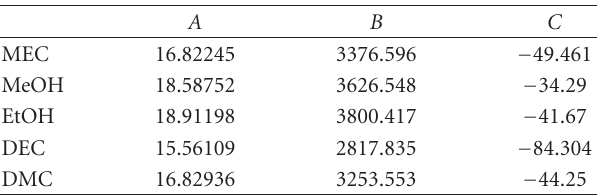
Table 5: The Antoine parameters. p o i is measured in (mmHg), and T is measured in [K]